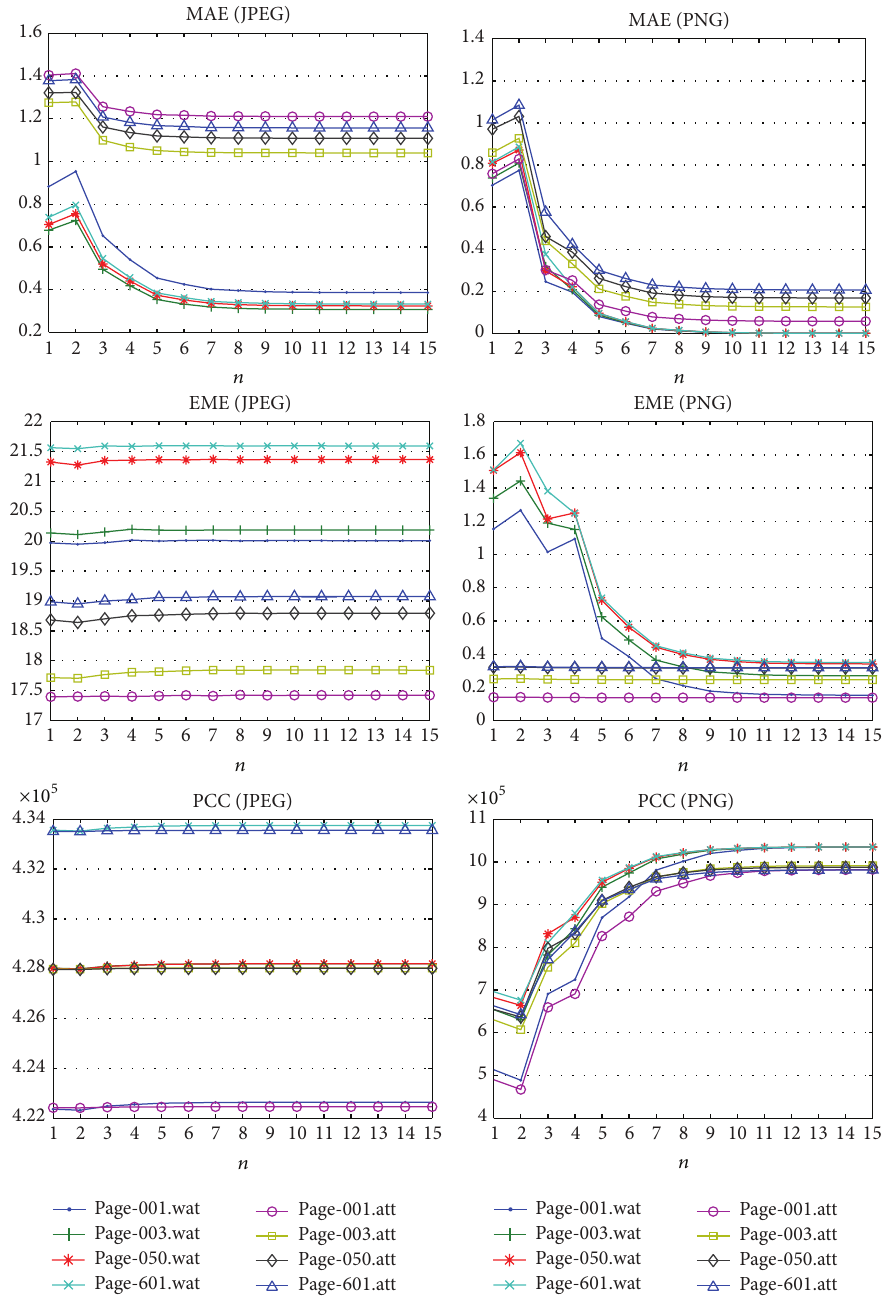
Figure 12: Image quality metrics on median filtering